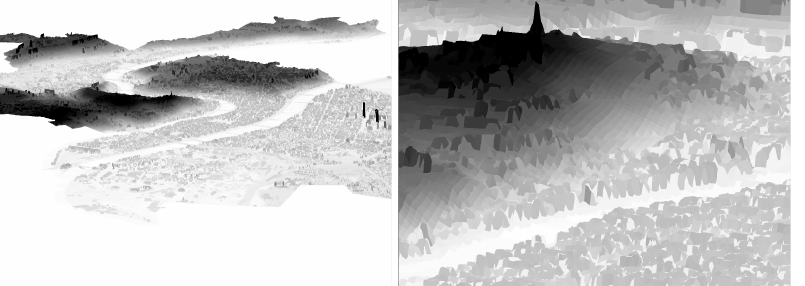
Figure 12. One-meter-resolution DEM used for a visibility analysis for the Lyon Metropolis: view from the whole DEM covering the city of Lyon (48 sq km) ( left ) and zoom on a specific part of the city ( right ).